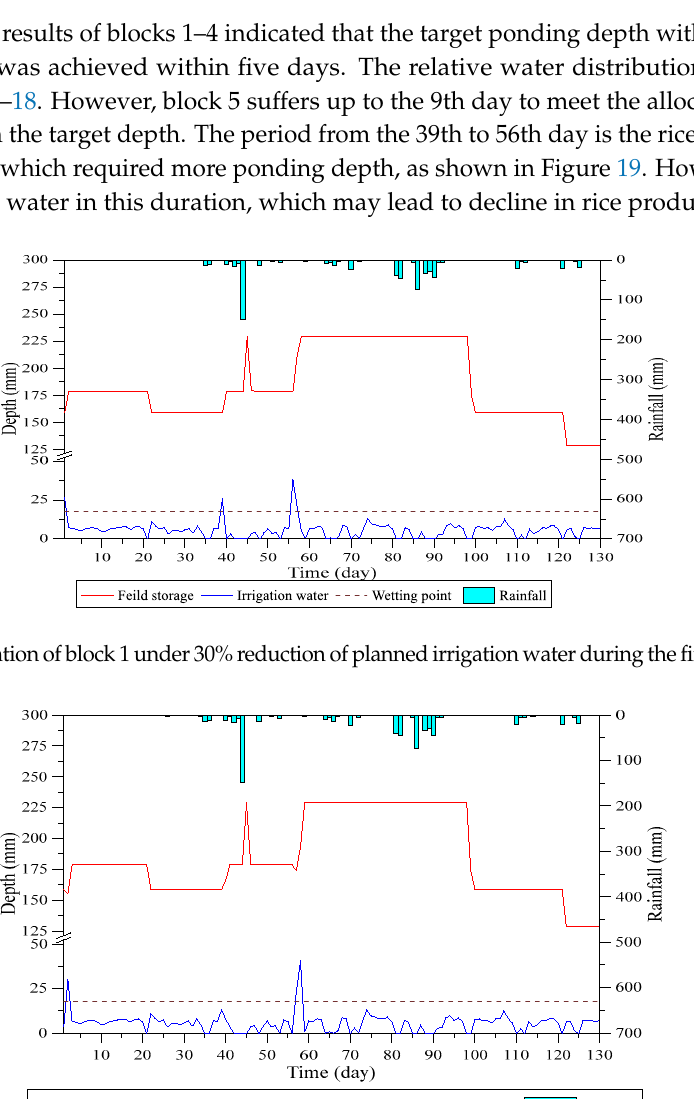
Figure 16. Simulation of block 2 under 30% reduction of planned irrigation water during the first crop season.